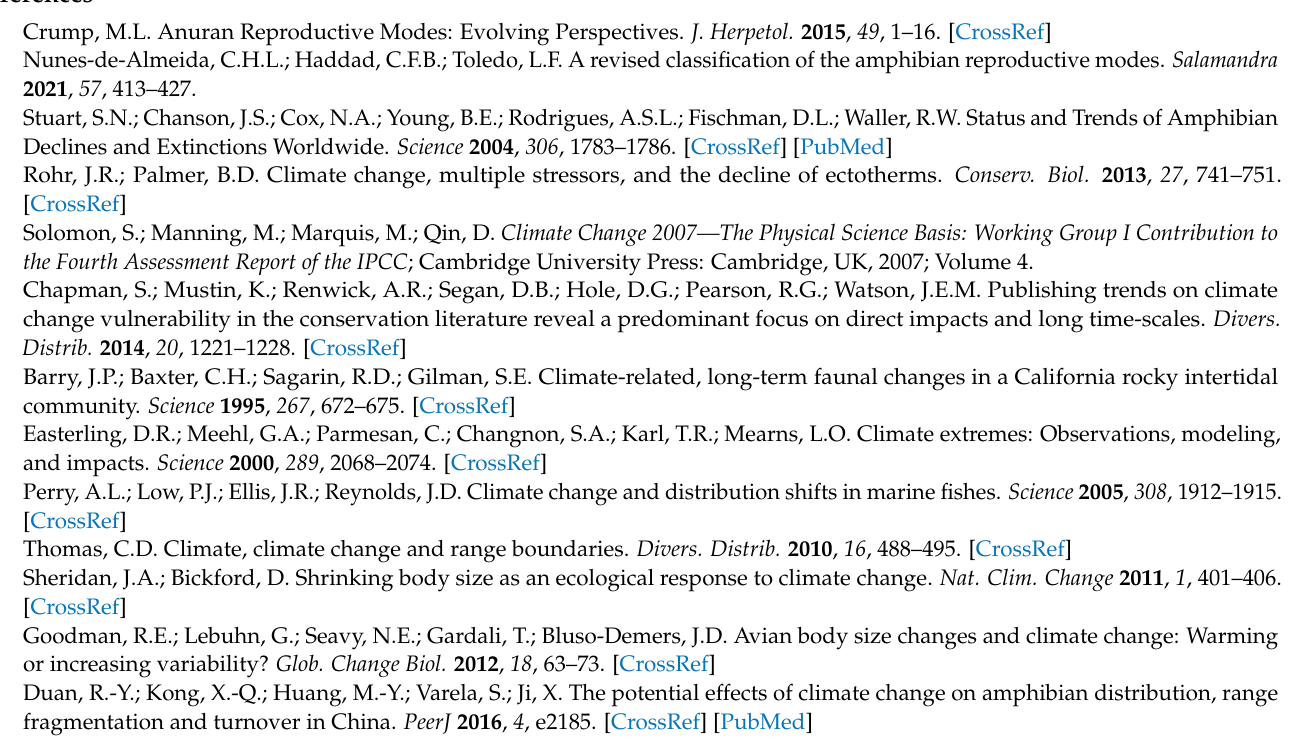
Table S2: KEGG functional enrichment results of up- and down-regulated DEGs. Table S3: GO functional enrichment results of up- and down-regulated DEGs. Table S4: Detailed information on differentially expressed genes